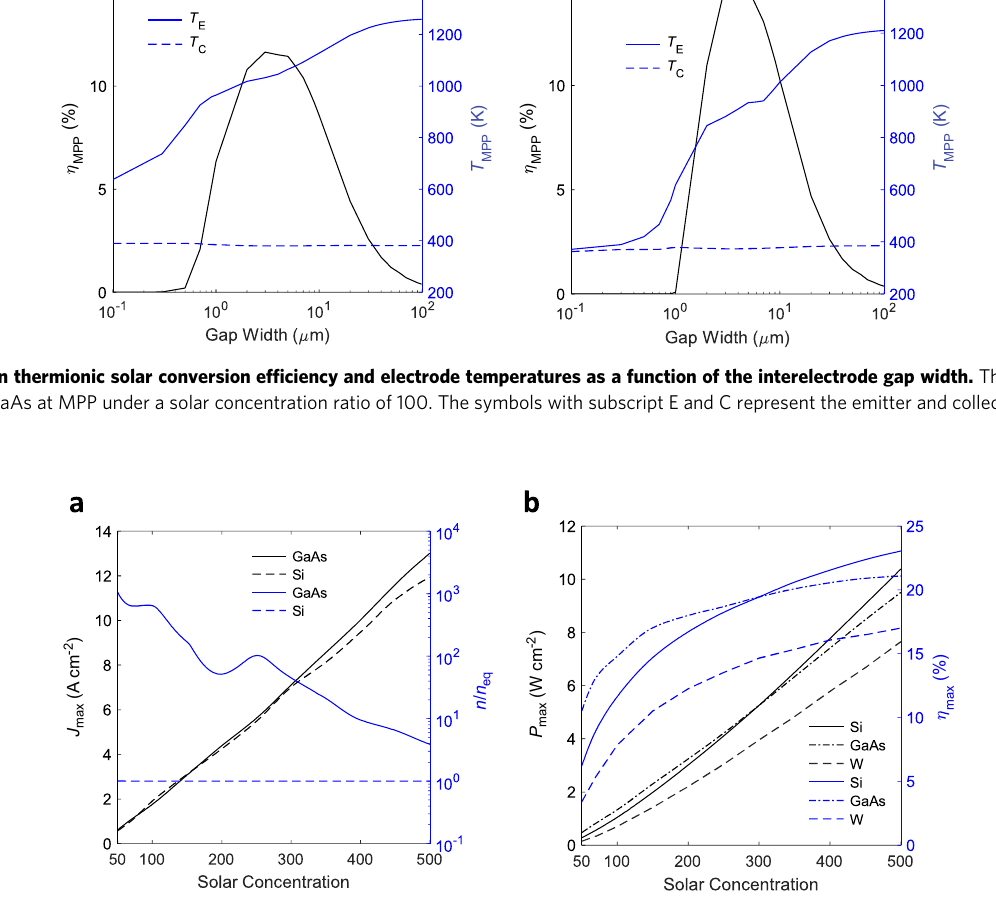
Fig. 5 Performance metrics of different gap-optimized thermionic solar converters. a MPP current density and the corresponding photon enhancement factor ( n / n eq ) for different semiconductor materials as a function of solar concentration ratio. n and n eq represent the conduction band electron density at the emitter surface under steady-state and equilibrium conditions, respectively. b MPP output power density and solar conversion ef fi ciency for different semiconductor materials as a function of solar concentration ratio. The performance of a tungsten device is also shown for comparison between metal and semiconductor